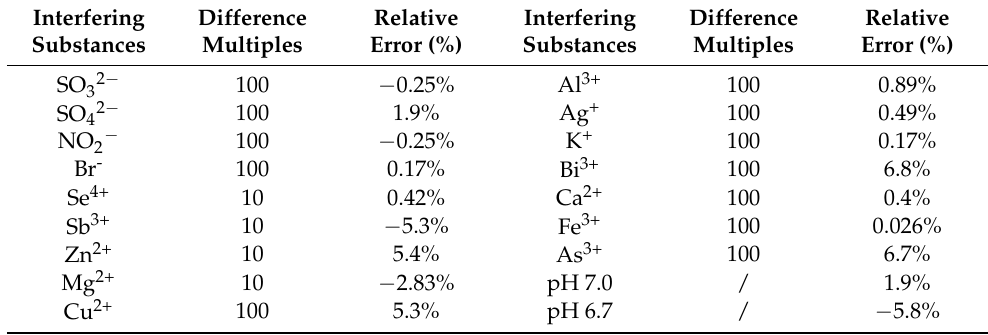
Table 1. Effects of Interfering Substances.